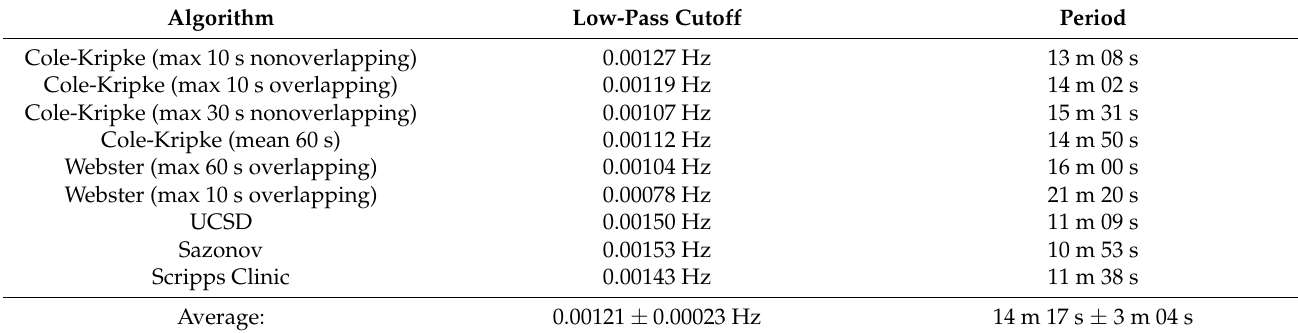
Table 1. Cutoff frequencies (at − 3dB) of low-pass filters corresponding to step (2.) of analyzed algorithms. Third column presents the corresponding periods in